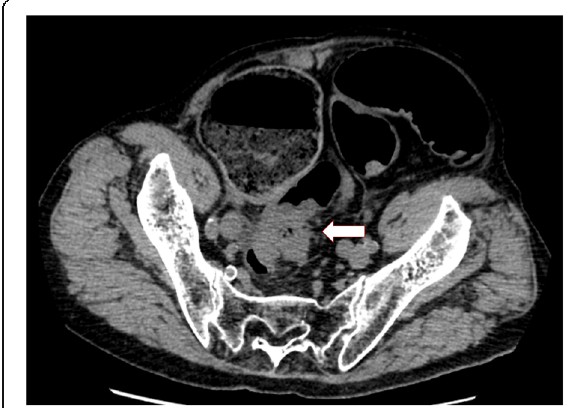
Fig. 1 Abdominal multi-detector computed tomography scan. Rectal tumor (white arrow) and distended bowel on the oral side can be seen